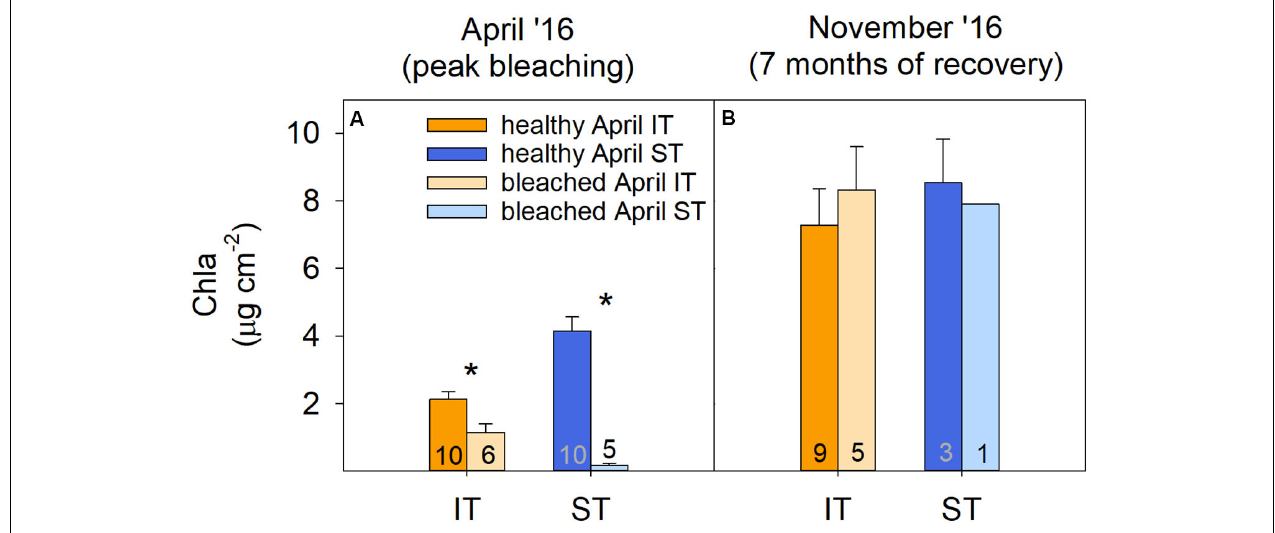
FIGURE 4 | Coral physiology. Chlorophyll a concentration of intertidal (IT) and subtidal (ST) Acropora aspera (all genetic lineages) in (A) April and (B) November 2016. Asterisks indicate significant differences between healthy and bleached/recovering corals within a specific environment and time point. Numbers indicate sample size per treatment. Note that only one of the tagged bleached subtidal corals survived.